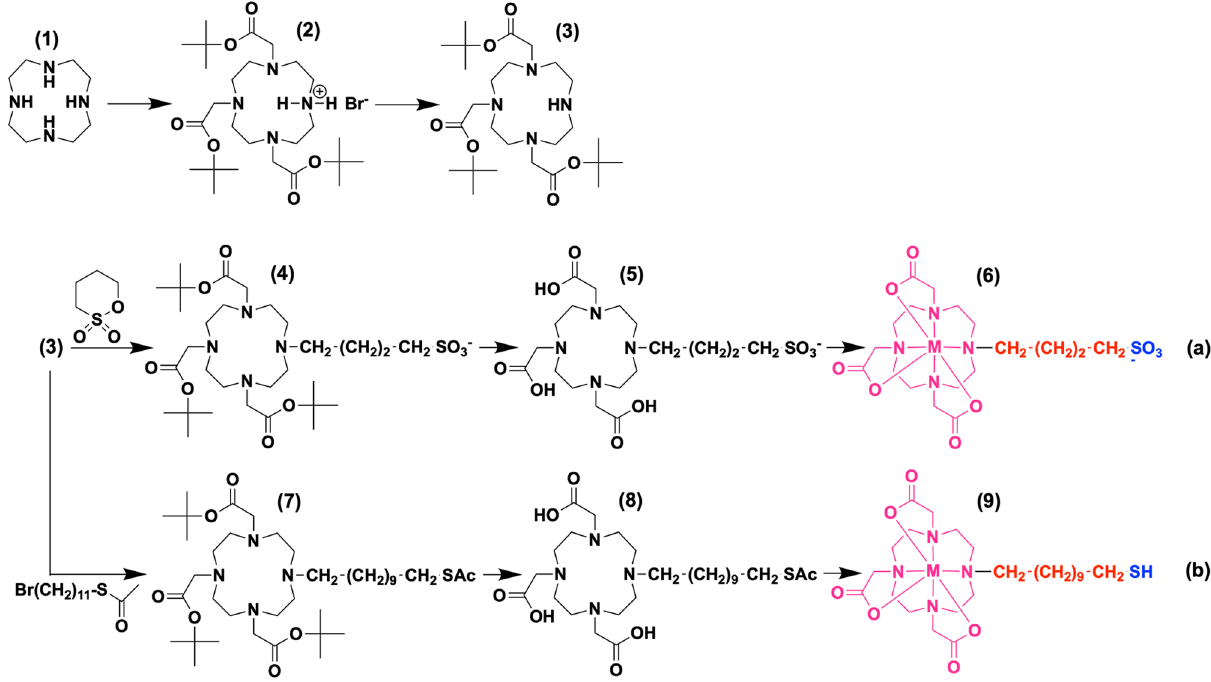
Figure 1. Synthesis routes to new surfactants with DO3A-metal complexes as constituents. ( a ) sulfonic acid terminated bolaform compounds M-DO3A-C 4 -SO 3 . ( b ) thiol terminated bolaform compound M-DO3A- C 11 -SH. Blue = hydrophilic; red = hydrophobic; purple = predominantly hydrophobic. M 3+ = Ce 3+ (i), Sc 3+ (ii), Yb 3+